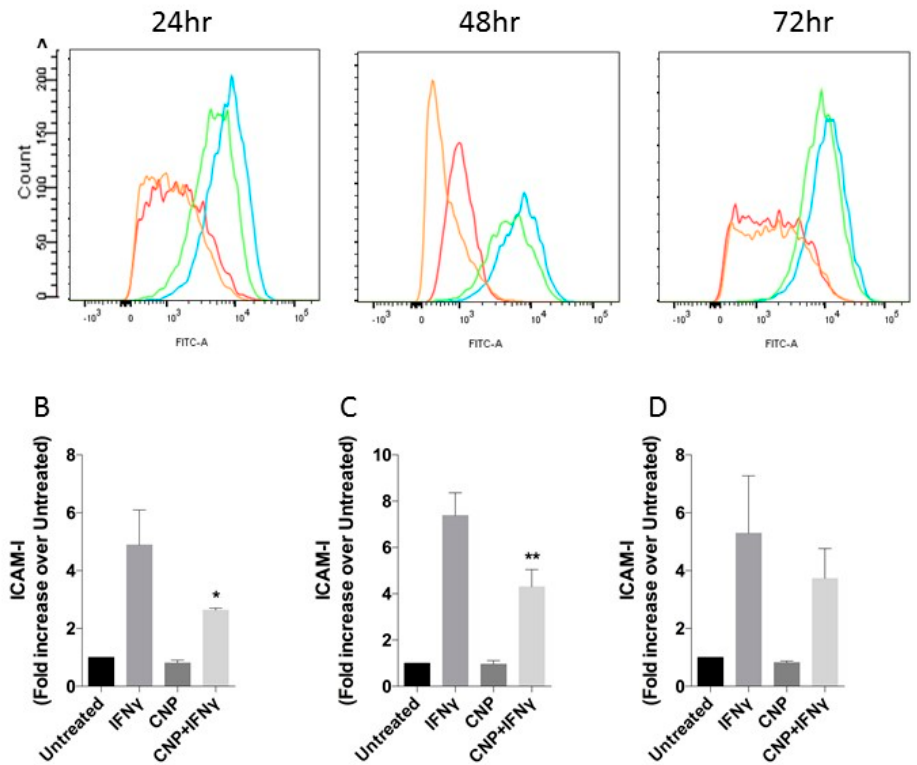
Figure 1. ICAM-1 expression in HUVEC after incubation with IFN- γ alone or in combinations with CNP for up to 72 h. ( A ) Representative flow cytometry histograms for ICAM-1 after incubation of HUVEC alone ( Red ) or with IFN- γ ( Blue ), CNP ( Orange ) or IFN- γ and CNP ( Green ) for the indicated times. ( B – D ) Mean Fluorescence Intensity (expressed as fold increase over MFI of untreated cells, which range from 820 to 3089; mean ± SEM) for ICAM-1 on untreated HUVEC or after 24 h ( B ), 48 h ( C ) or 72 h ( D ) treatment with IFN- γ alone or in combination with CNP; n = 3 HUVEC isolates (* p < 0.05, ** p < 0.01, significantly different from IFN- γ alone).